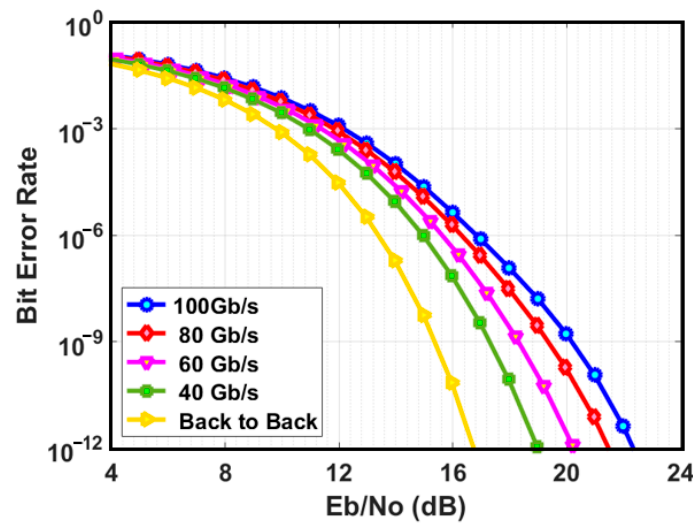
Figure 10. Bit error rate (BER) performance comparison between various data rates (40, 60, 80, and 100 Gb/s) of an RZ-DQPSK modulated signal after a 390-km transmission using a three-segment hybrid fiber core structure.